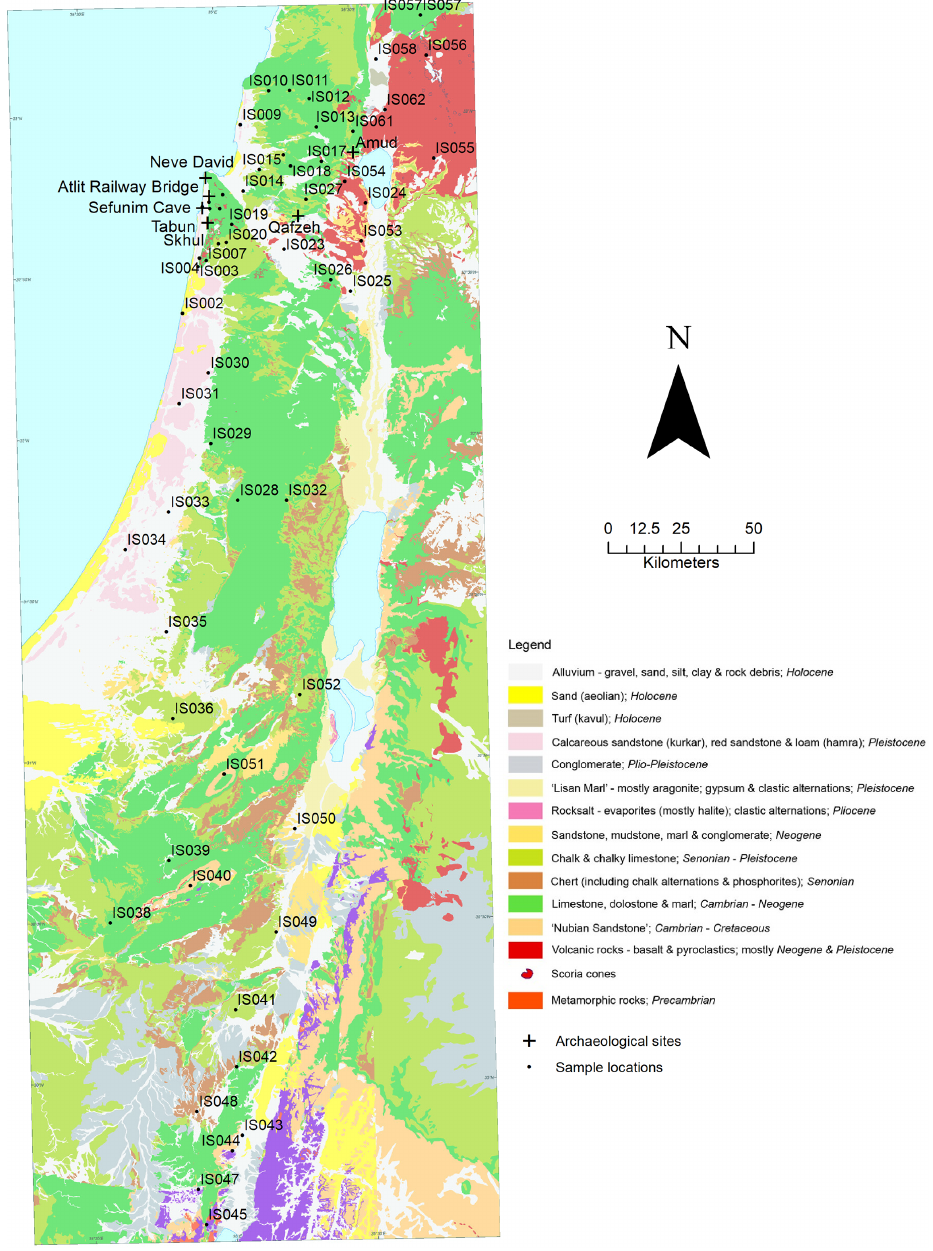
Figure 1. Sampling locations overlain on a lithological map of Israel (adapted from Sneh and Rosensaft,